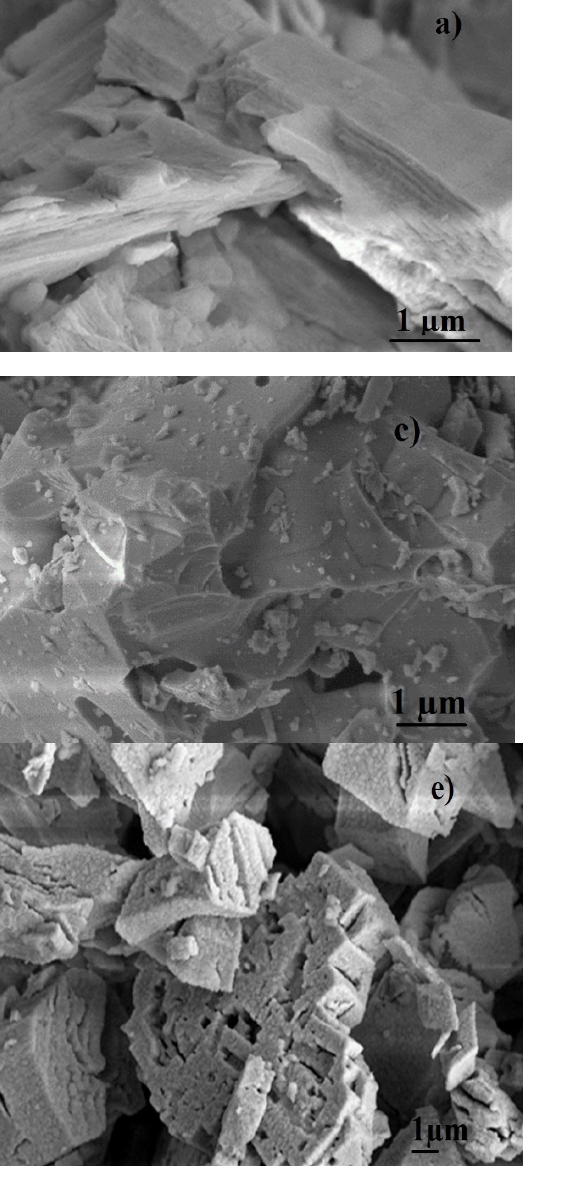
Figure 2. SEM images of the powders at different scales: ( a , b )—Tm 2 O 3 ; ( c , d )—Bi 2 O 3 ; ( e , f )— Bi 2 O 3 /Tm 2 O 3 . Insert—size distribution of the